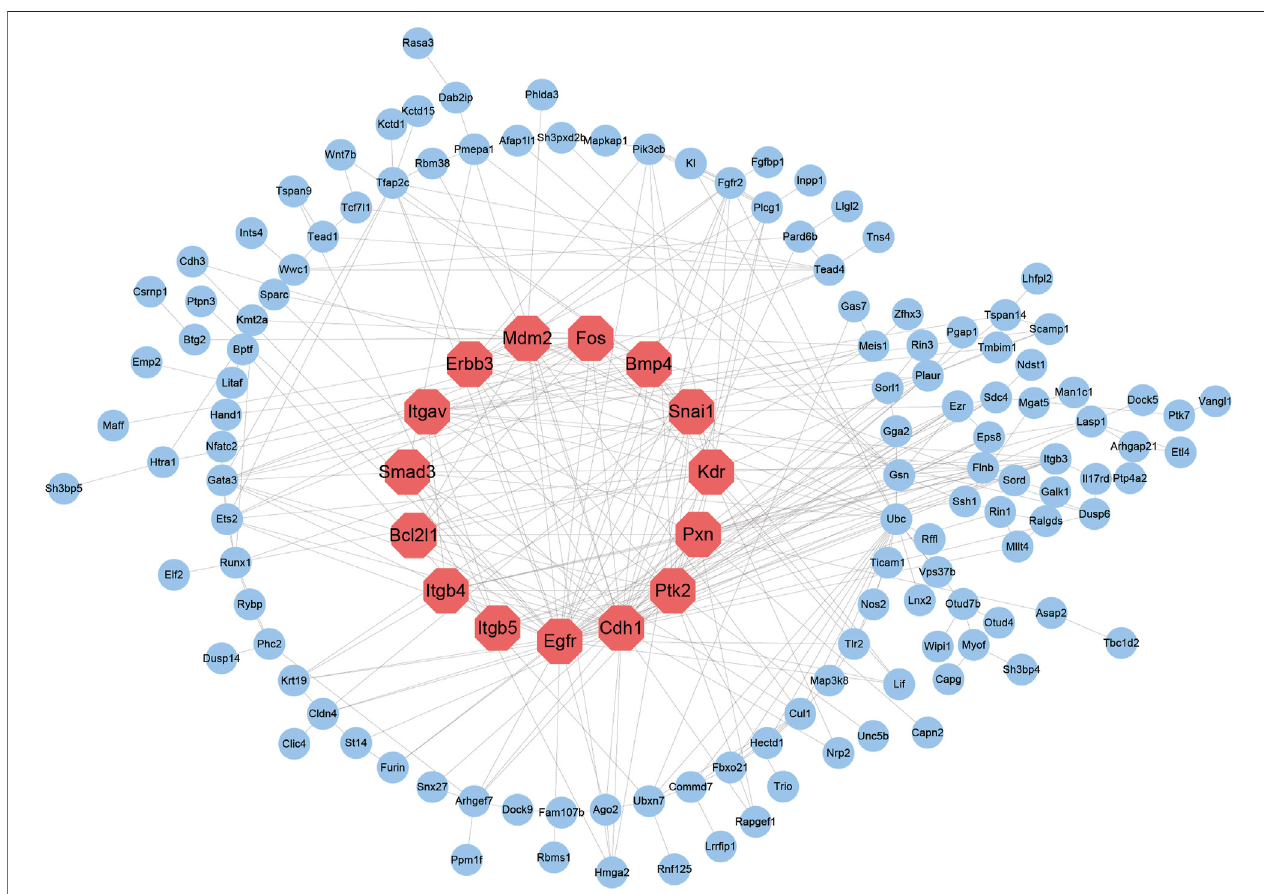
FIGURE 5 | Establishment of the TSC-speci fi c SE PPI network. The top 15 nodes with the highest degrees of connectivity are marked in red, and the node sizes represent the degrees.